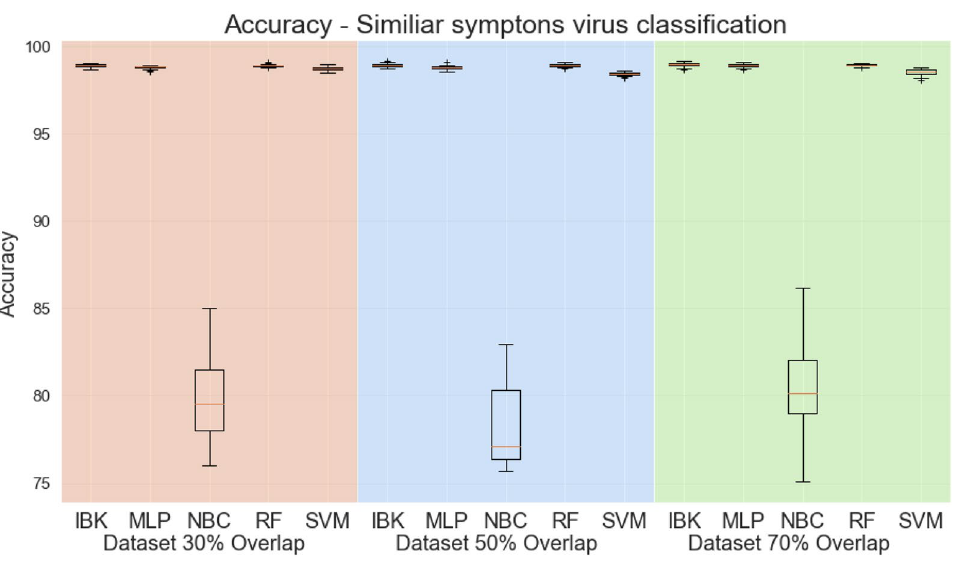
Figure 12. Accuracy for similar symptoms